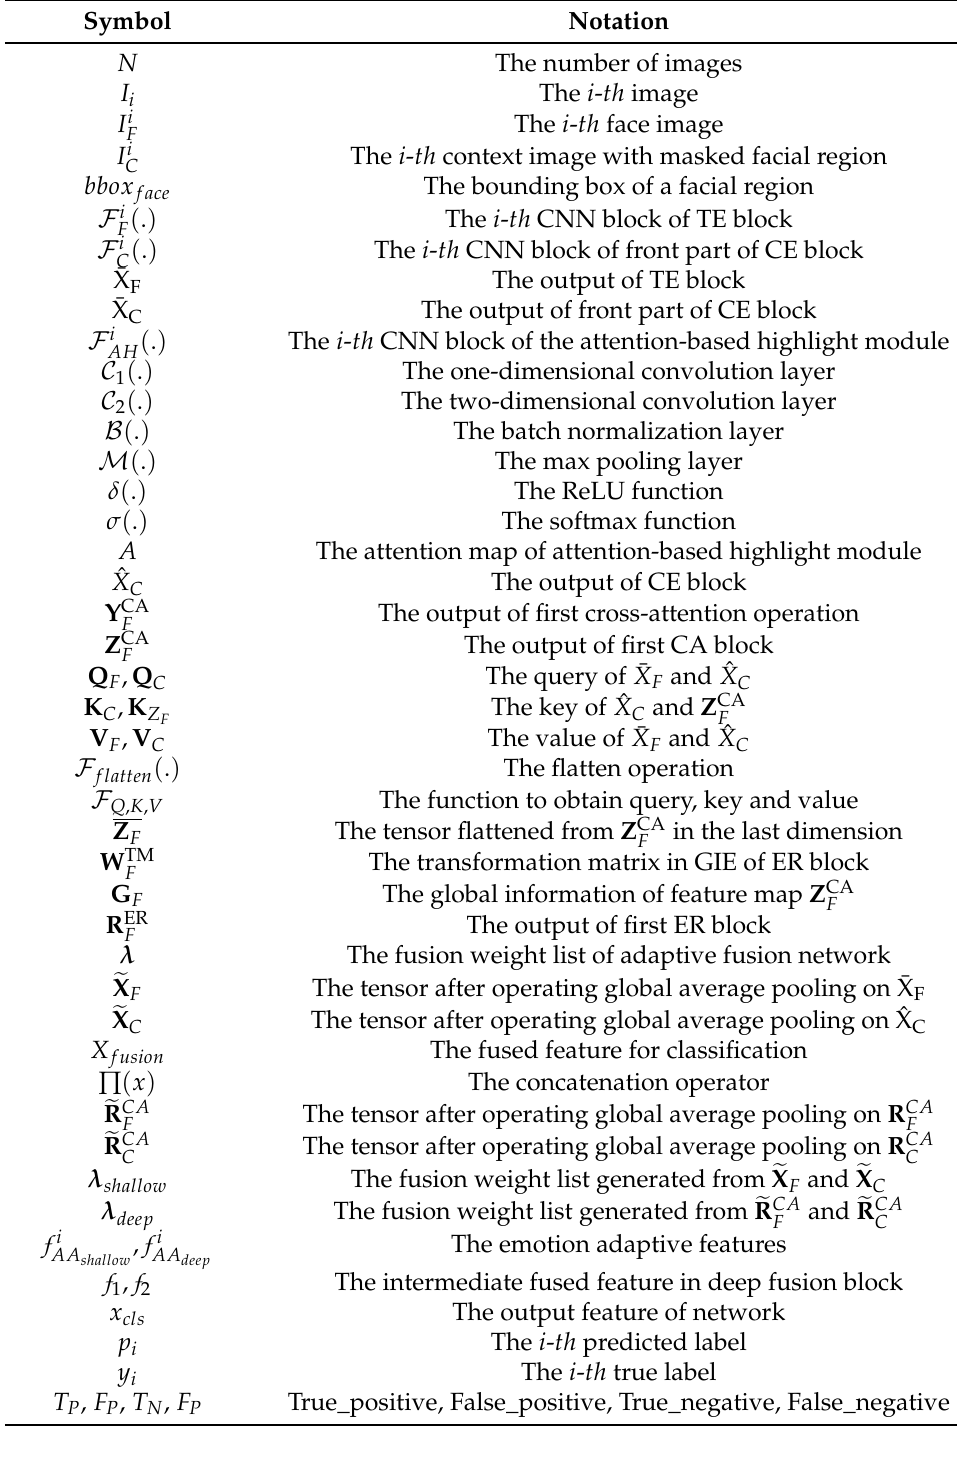
Table 1. Summary of the mathematical notations used in this